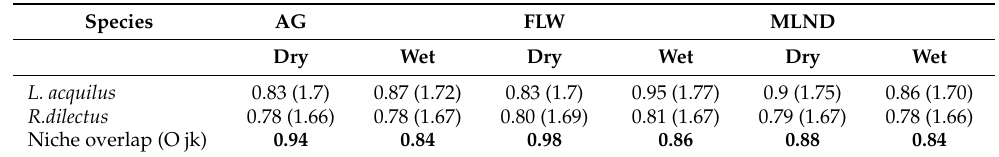
Table 5. Niche breadth, diet diversity (in parentheses), and niche overlap (O jk ) between species j ( L. acquilus ) and species k ( R. dilectus ) across the habitats (AG: agricultural field; FLW: fallow land; and MLND: moorland) and seasons. Niche breadth or Levin’s Index of food diversity ranges from 0 to 1, where 1 = highest diversity and 0 = lowest diversity, also niche overlap ranges from 0 (no overlap) to 1 (total overlap). Species AG FLW MLND